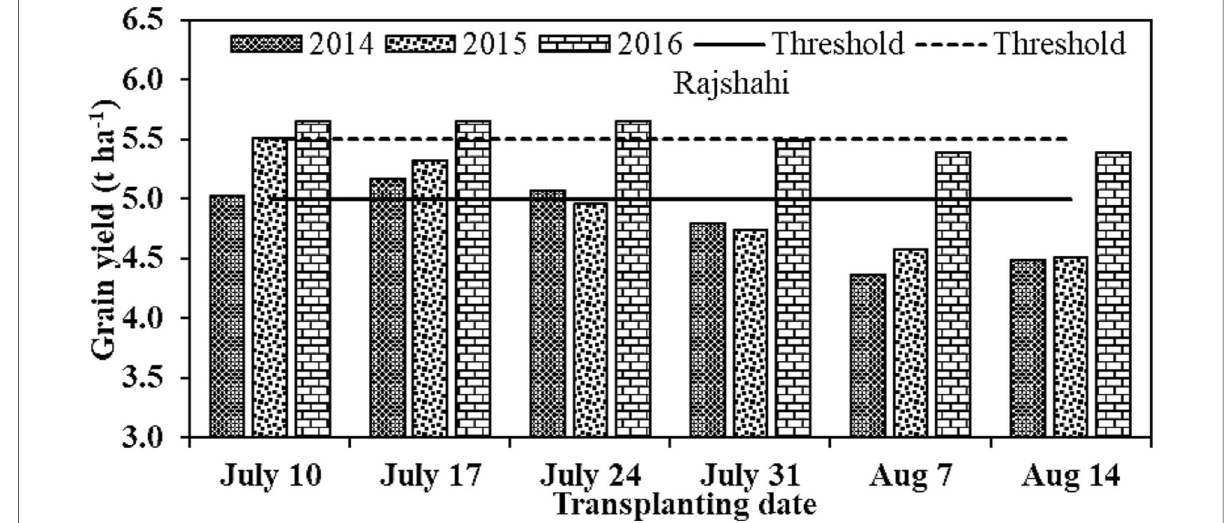
Fig. 7 Yield comparison of BR11 with threshold limit under varying transplanting date in